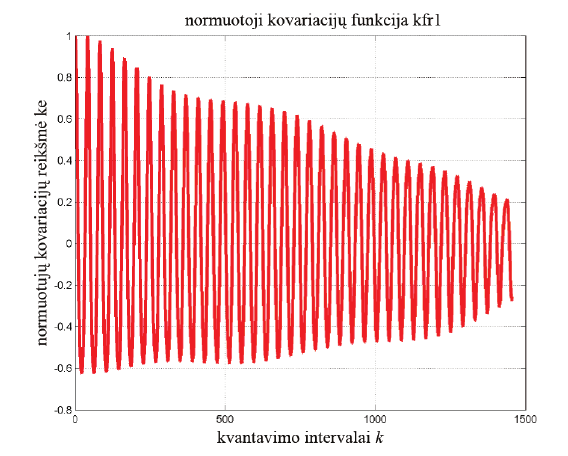
Fig. 2 . Normalised covariance function of the normal male first chromosome 21 in